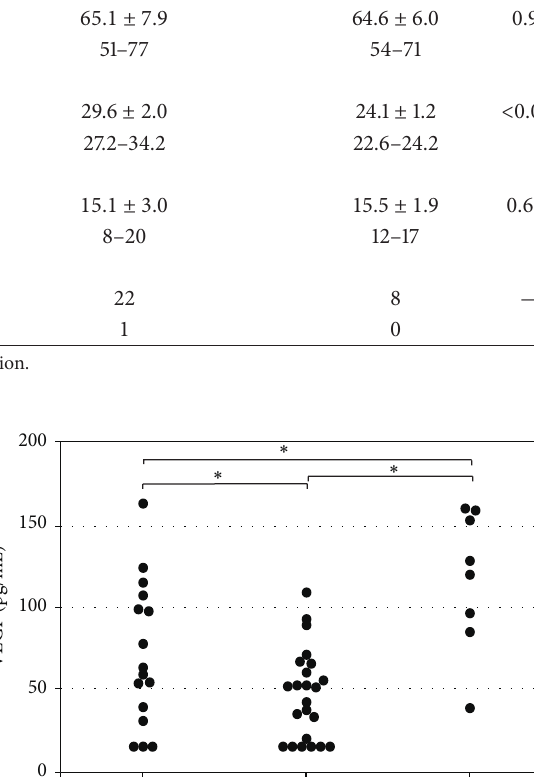
Therefore, the VEGF concentration may be diluted because of the large vitreous cavity due to the elongated axial length in highly myopic eyes. It is uncertain if the low aqueous levels of VEGF represent decreased production of VEGF from endo- thelial cells and retinal pigment epithelium (RPE) in highly myopic